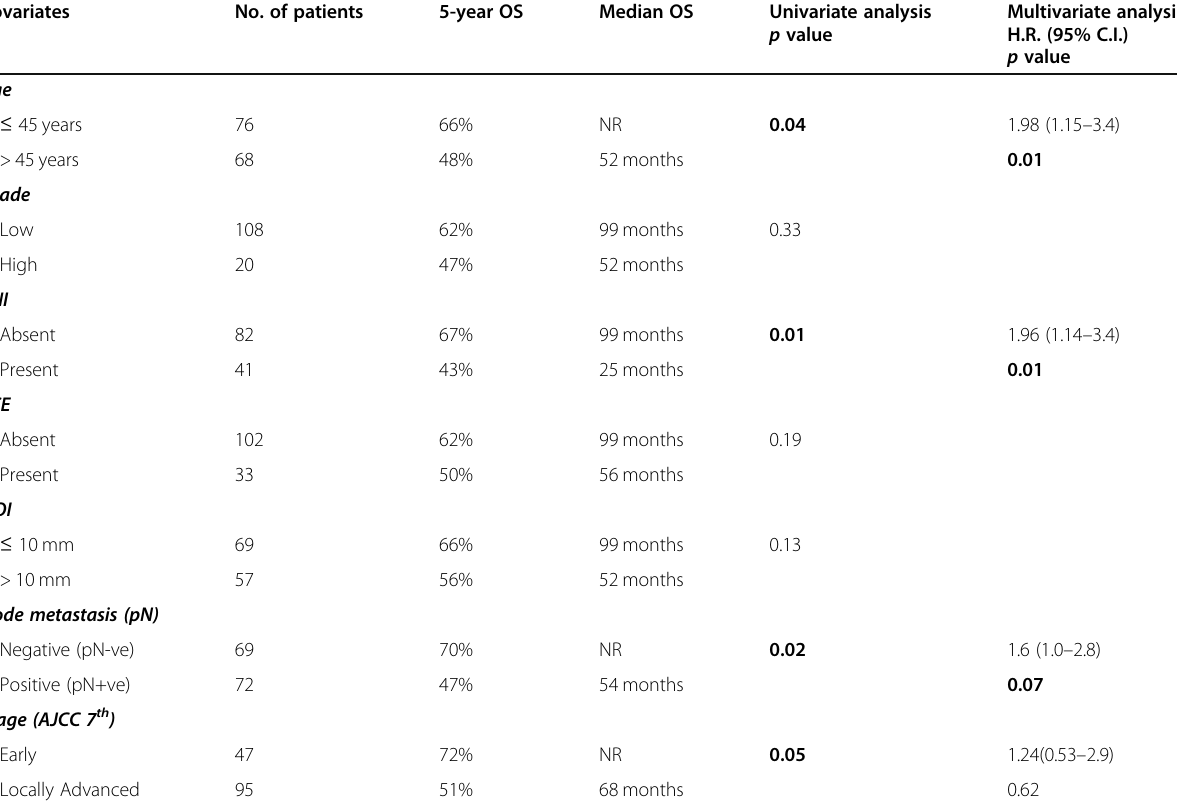
Table 4 Impact of prognostic factors on overall survival (OS) in study cohort ( N = 144) Covariates